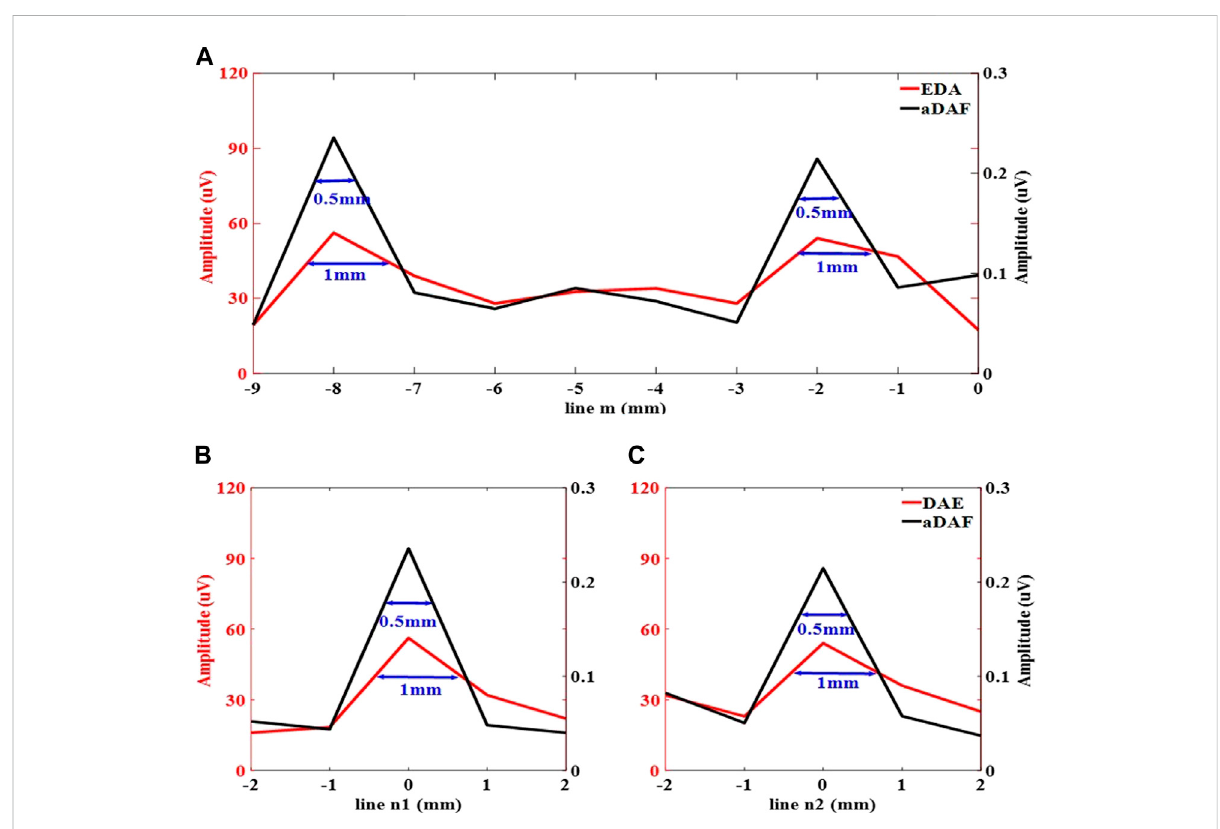
FIGURE 7 Line pro fi les of the decoded signal along the white dashed lines m, n1 and n2 marked in (A) along line m, (B) along line n1, (C) along line